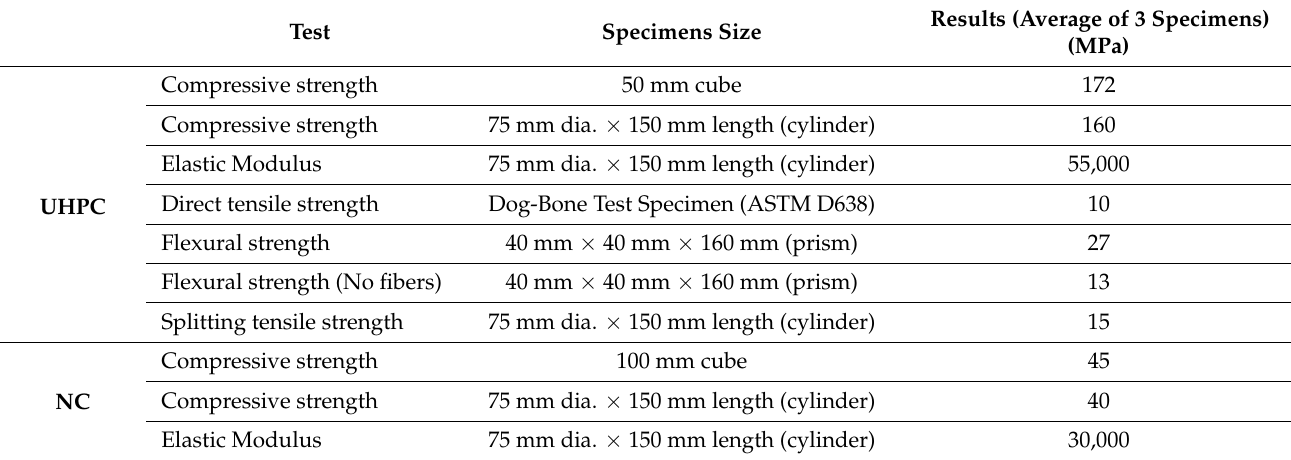
Table 5. Test results of UHPC and NC used in hybrid